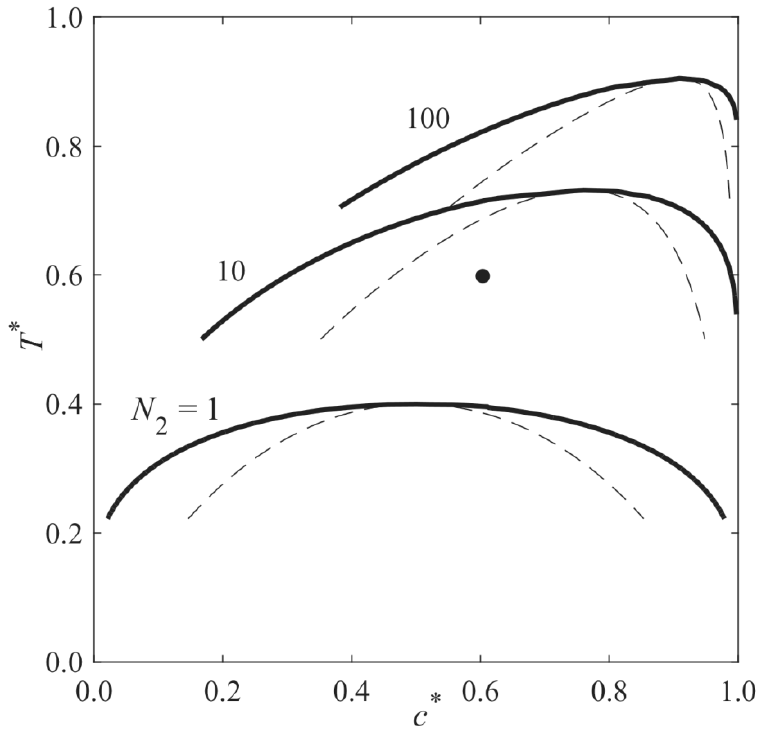
Figure 1. Phase diagram of a binary mixture undergoing the polymerization-induced phase sepa- ration. Using Flory–Huggins free energy density, the diagrams are calculated, where ψ = 1, N 1 = 1, and from bottom to top, N 2 = 1, 10, and 100.